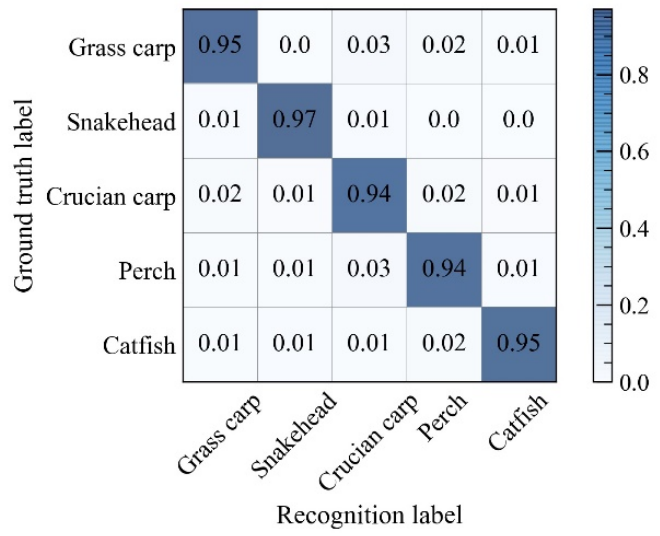
Figure 6. Confusion matrix of recognition results.